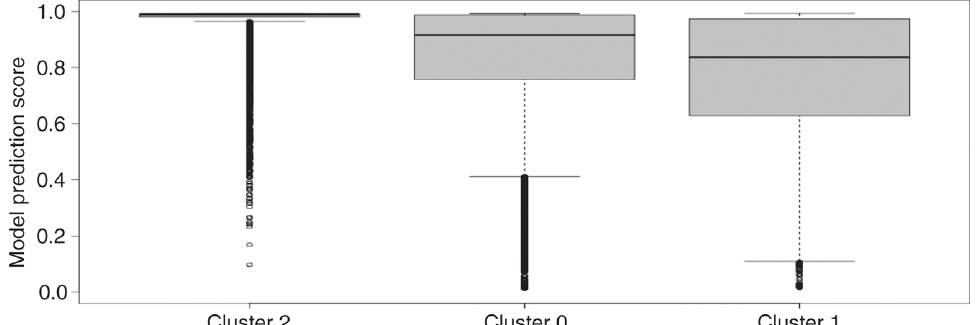
Figure 3: Clustering of miRBase hairpins. Out of 259 hairpins identical to MirGeneDB 145 of them located in Cluster 2, 24 of them are found in Cluster 1 and 90 are placed in Cluster 0. Overall Cluster 0 has 16,652 hairpins, Cluster 1 has 2801 hairpins, Cluster 2 has 9191